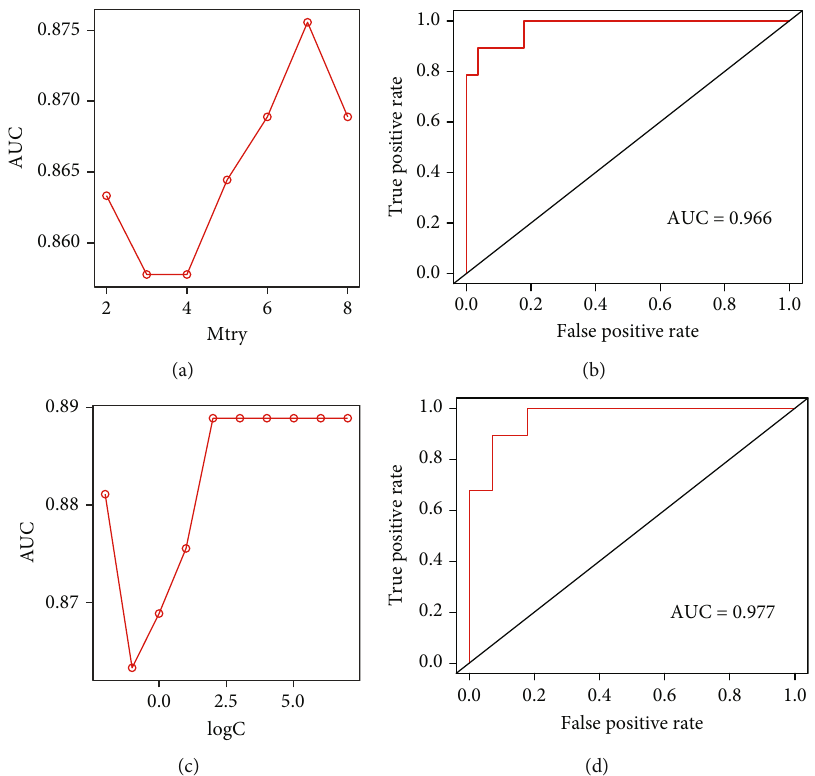
Figure 7: Construction and validation of machine learning models for predicting NPC subtypes. (a) Parameter optimization of RF model by 5-fold cross-validation in the training set. The mtry: number of variables randomly sampled as candidates at each split. (b) ROC curve analysis of the performance of RF in the test set. (c) Parameter optimization of SVM model by 5-fold cross-validation in the training set. C parameter in SVM is penalty parameter of the error term. (d) ROC curve analysis of the performance of RF in the test GSE35640 (Figure 8(a)), GSE78220 (Figure 8(b)), GSE111636 (Figure 8(c)), and IMvigor210 (Figure 8(d)) were 0.22, 0.41, 0.50, and 0.21. S1 patients were linked with better OS than S2 (Figure 8(e)).